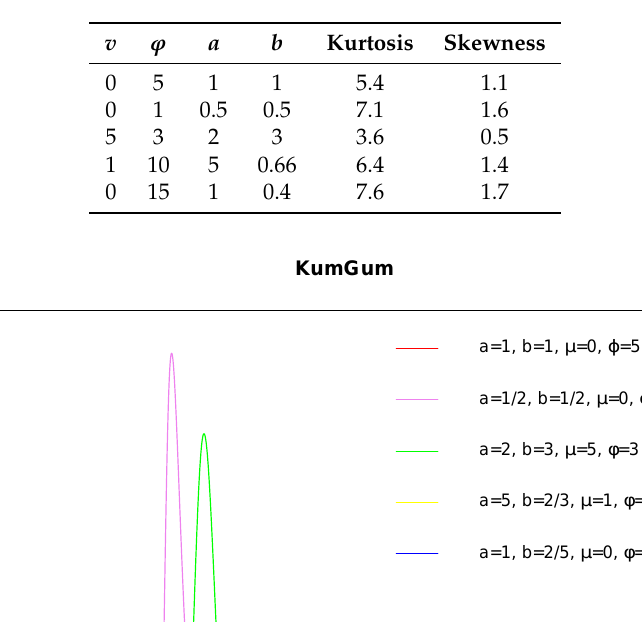
Table 3. Kurtosis and Skewness of the KumGum distribution.